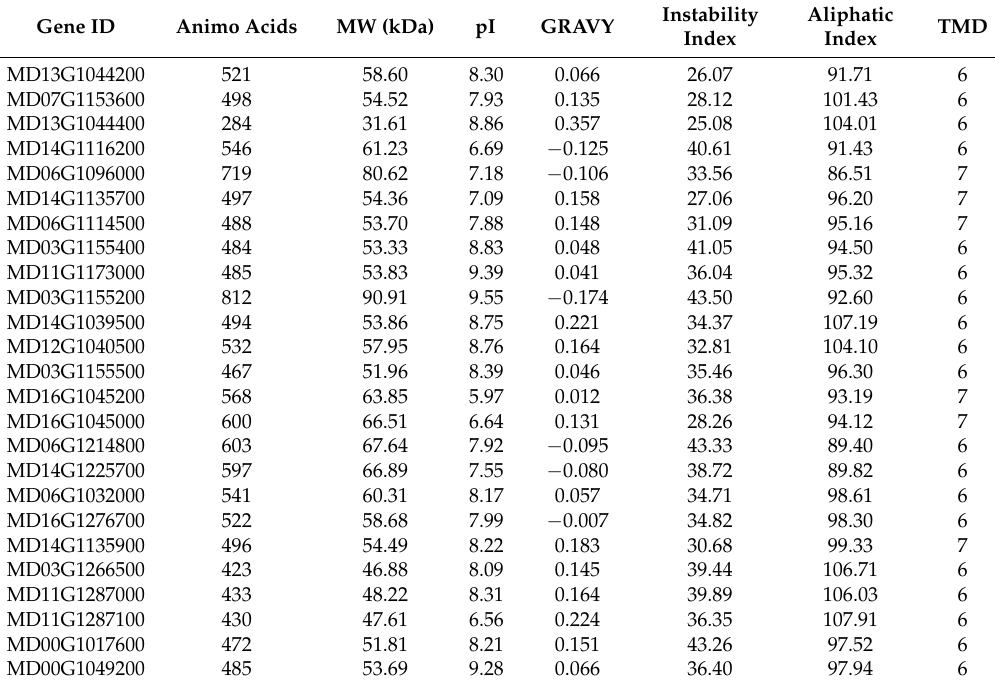
Table 1. Summary information of physiological and biochemical properties of the MdALMT